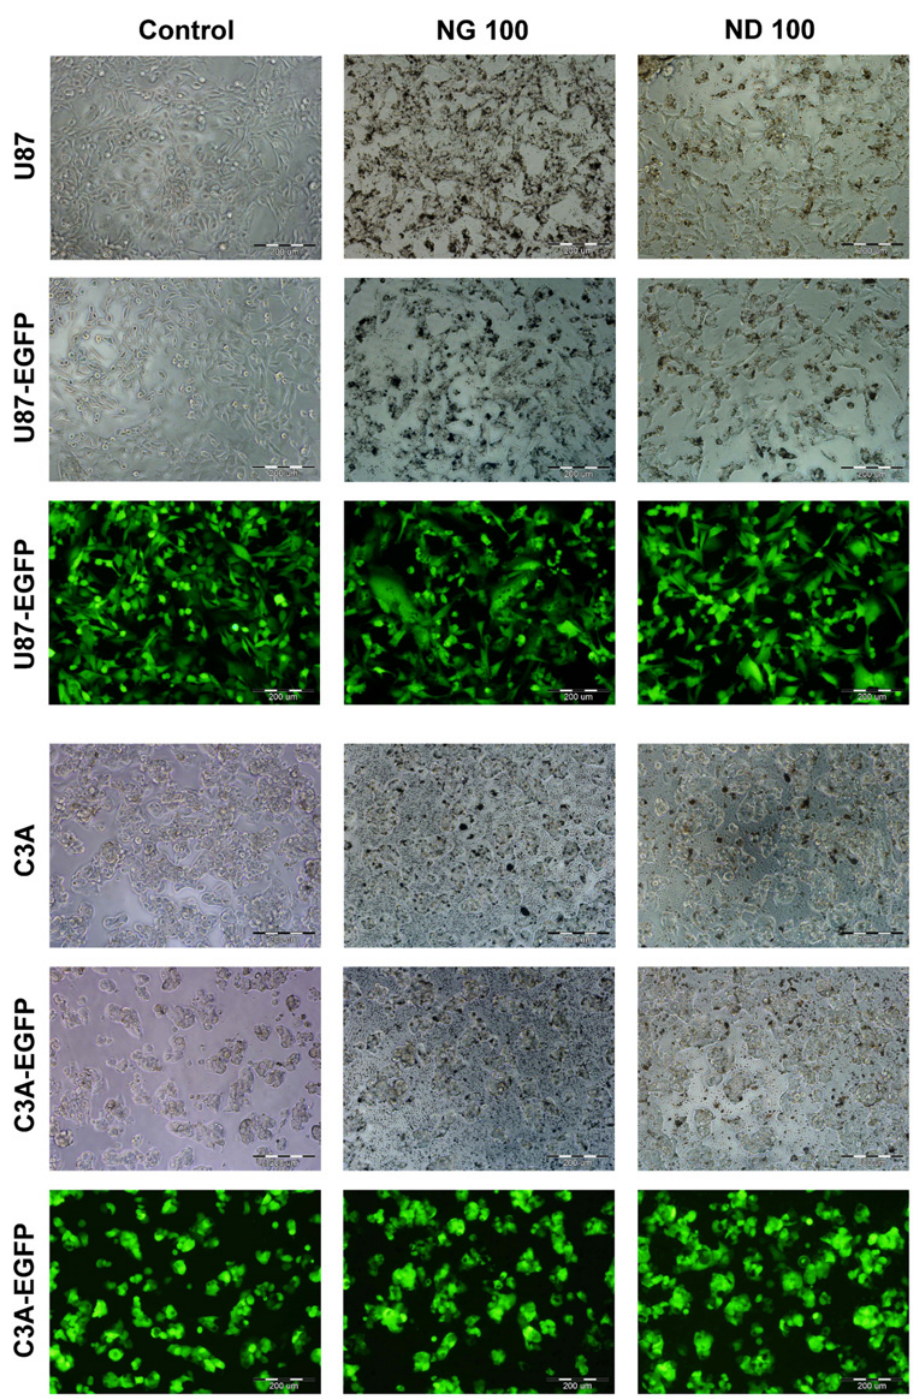
Fig 2. Glioblastoma and hepatoma cells morphology. U87, U87-EGFP, C3A and C3A-EGFP cells morphology after 2 h exposure to medium containing nanoparticles at the highest concentration: graphite 100 μ g/mL (NG 100) and diamond 100 μ g/mL (ND 100), nontreated cells were used as a control (Control). Analysis of the cells morphology was performed using an inverted fluorescence microscope. Images of the labeled cells, U87-EGFP and C3A-EGFP, were captured using a green fluorescence filter. Scale bar: 200 μ m.